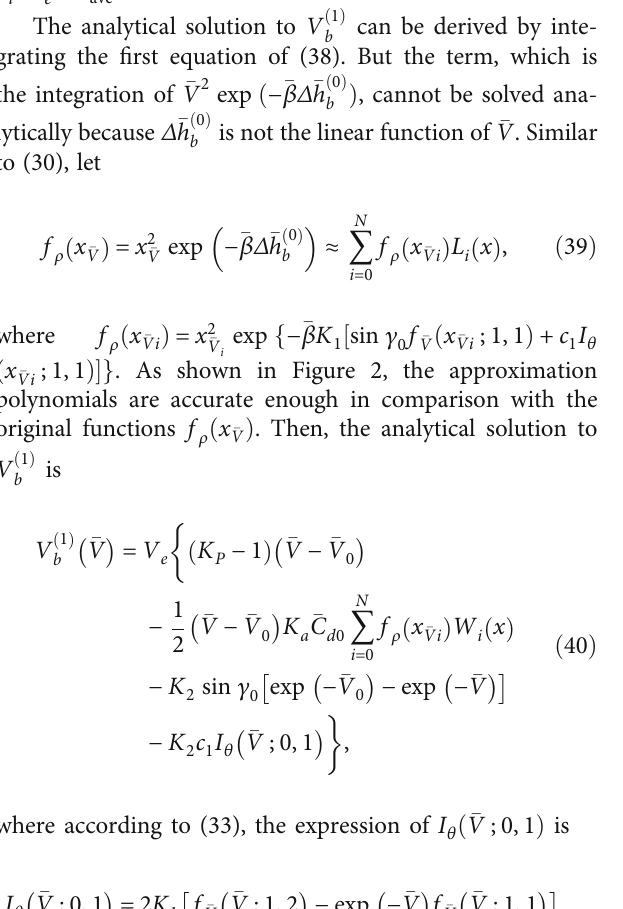
Figure 2: Comparison between f